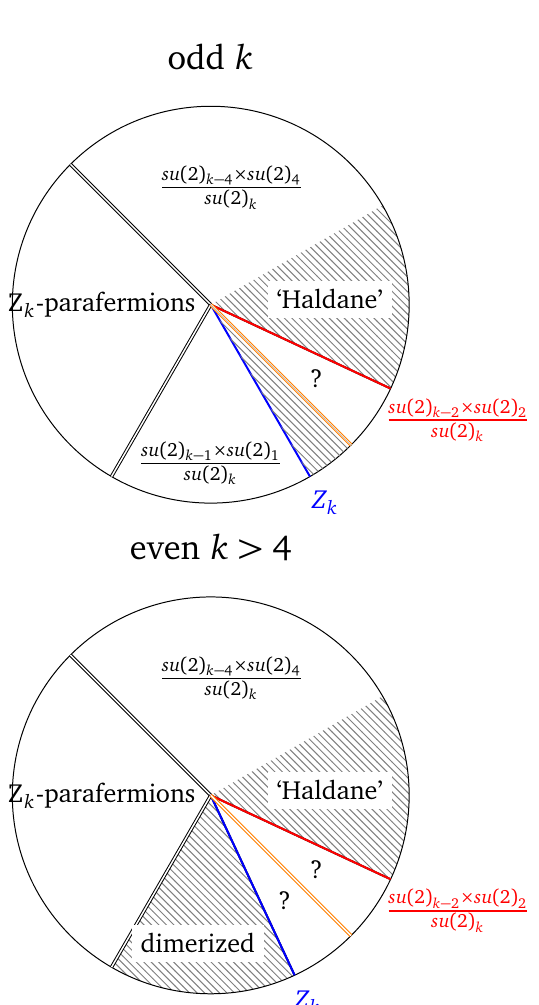
= θ , θ , θ 2,1 IK FZ TL is not critical, TL is described by a parafermionic Z k IK phase. For k odd we conjecture that it should k ( 2 ) × su ( 2 ) k − 2 2 phase and a new massive phase, su ( 2 ) k